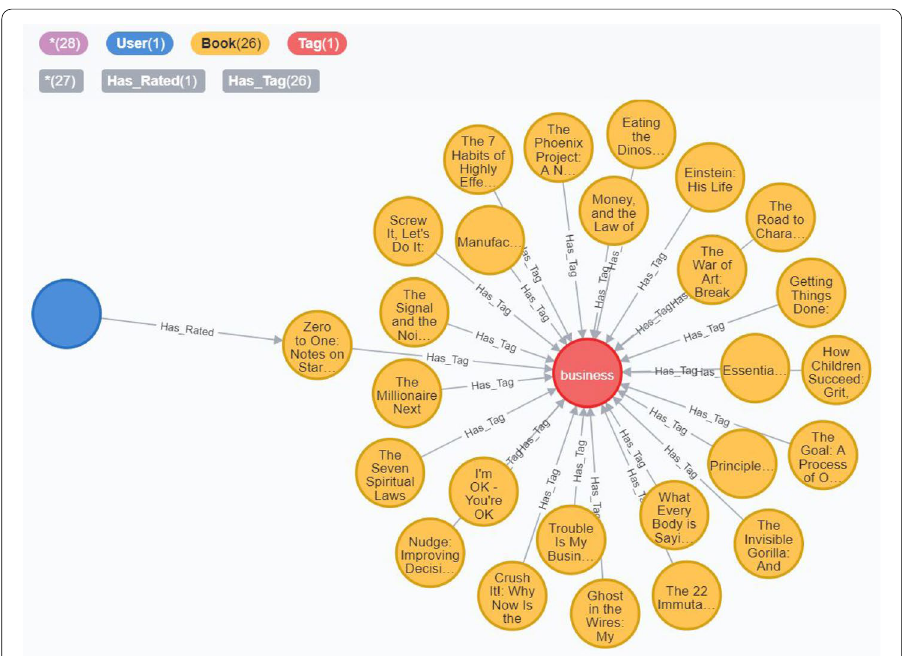
Fig. 9 Cypher Query (3)- KG : Discovery Recommendation Based on Knowledge